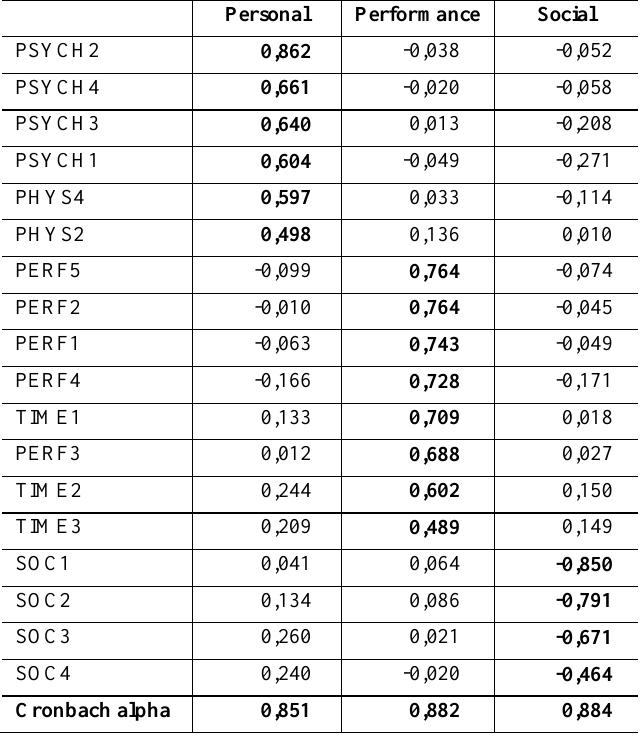
Table 1: Exploratory factor analysis results (risk types) Personal